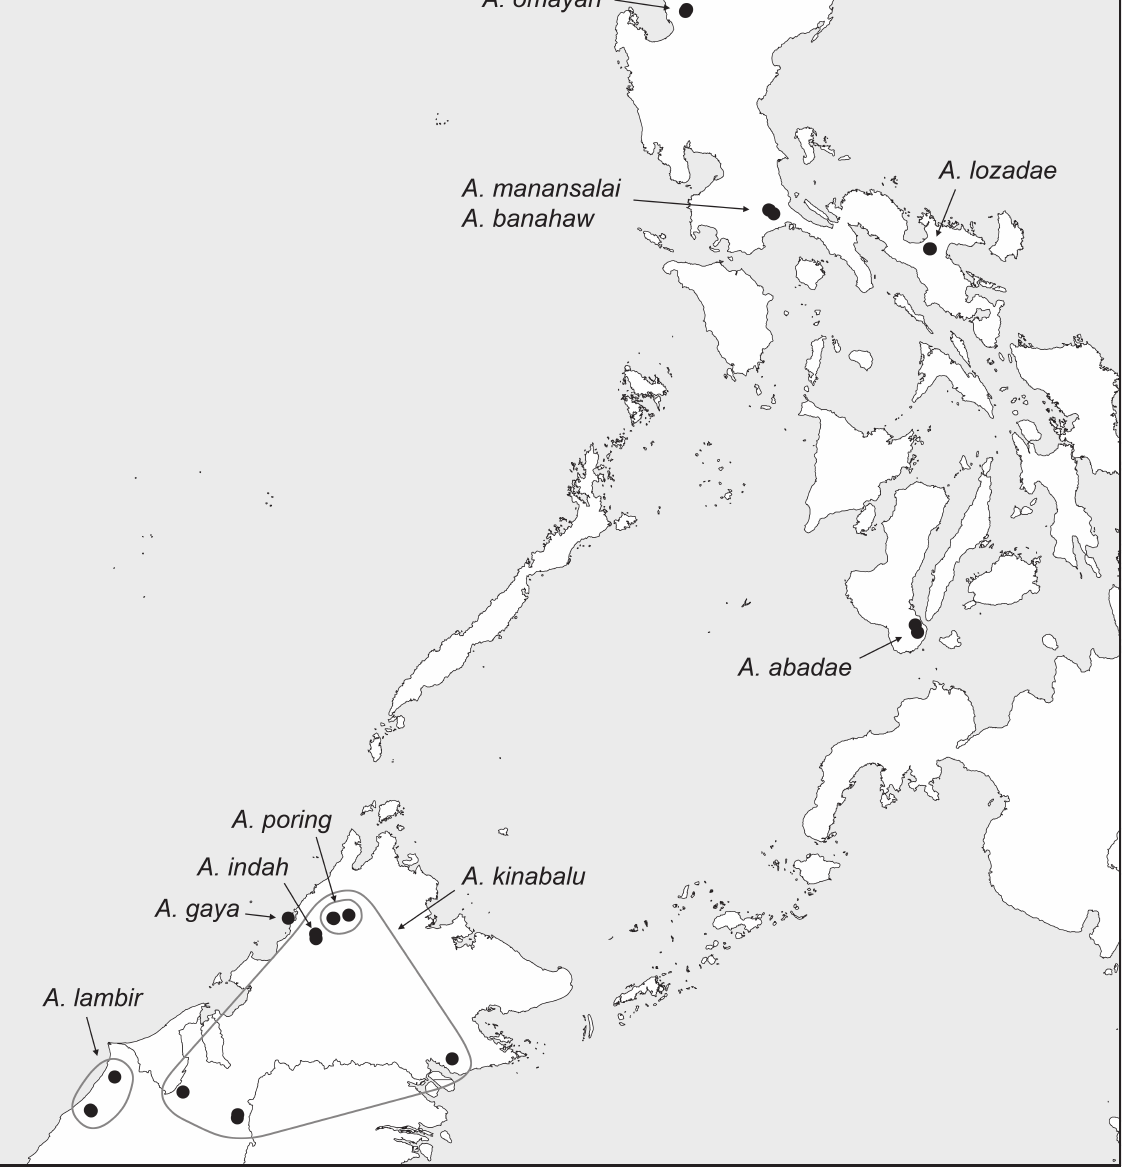
Fig. 5. Known distributions of the Aetana kinabalu (Borneo) and A. omayan (Philippines)